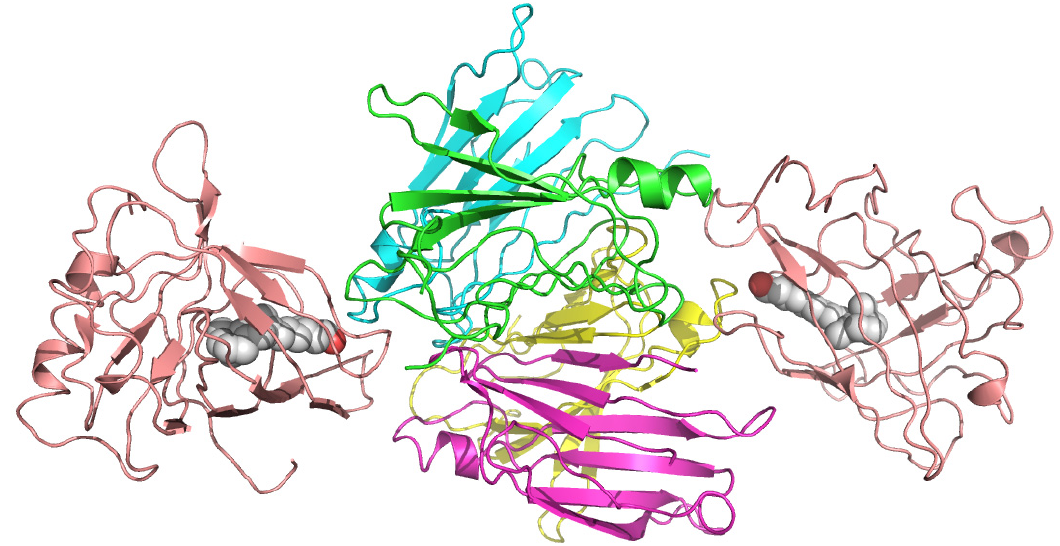
Figure 8. Crystal structures of the hexameric complex of human retinol-binding protein (RBP) with its carrier protein transthyretin. The RBP molecules are shown in salmon red, one of the TTR dimers is in green and yellow, and the other is in blue and magenta. The retinol molecules are represented as space-filling models with white carbon atoms and a hotpink oxygen. The illustration was produced by PyMol using the atomic coordinates from the Protein Data Bank, PDB 1QAB